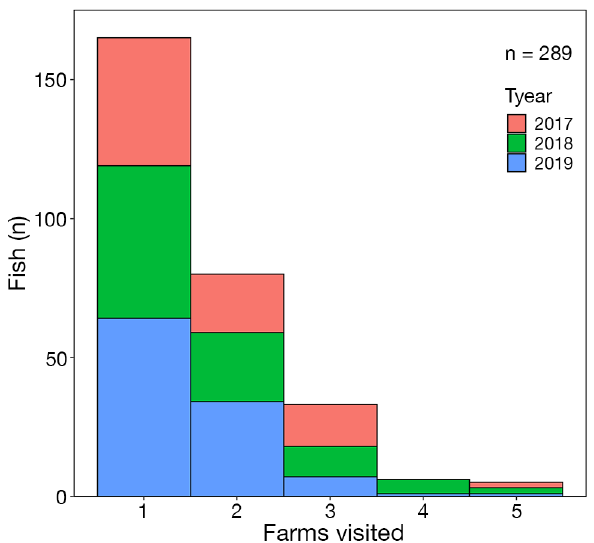
Fig. 7. Number of salmon farms visited by individual cods (n = 289 cod detected at all farms). Tyear: tagging year